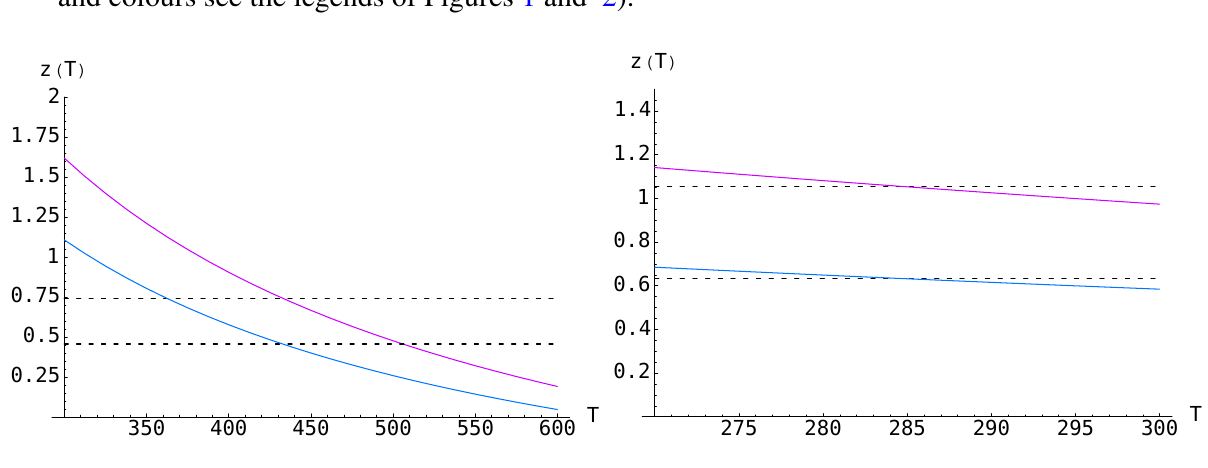
( T ) ; left TEG, right TEC (for boundary temperatures opt